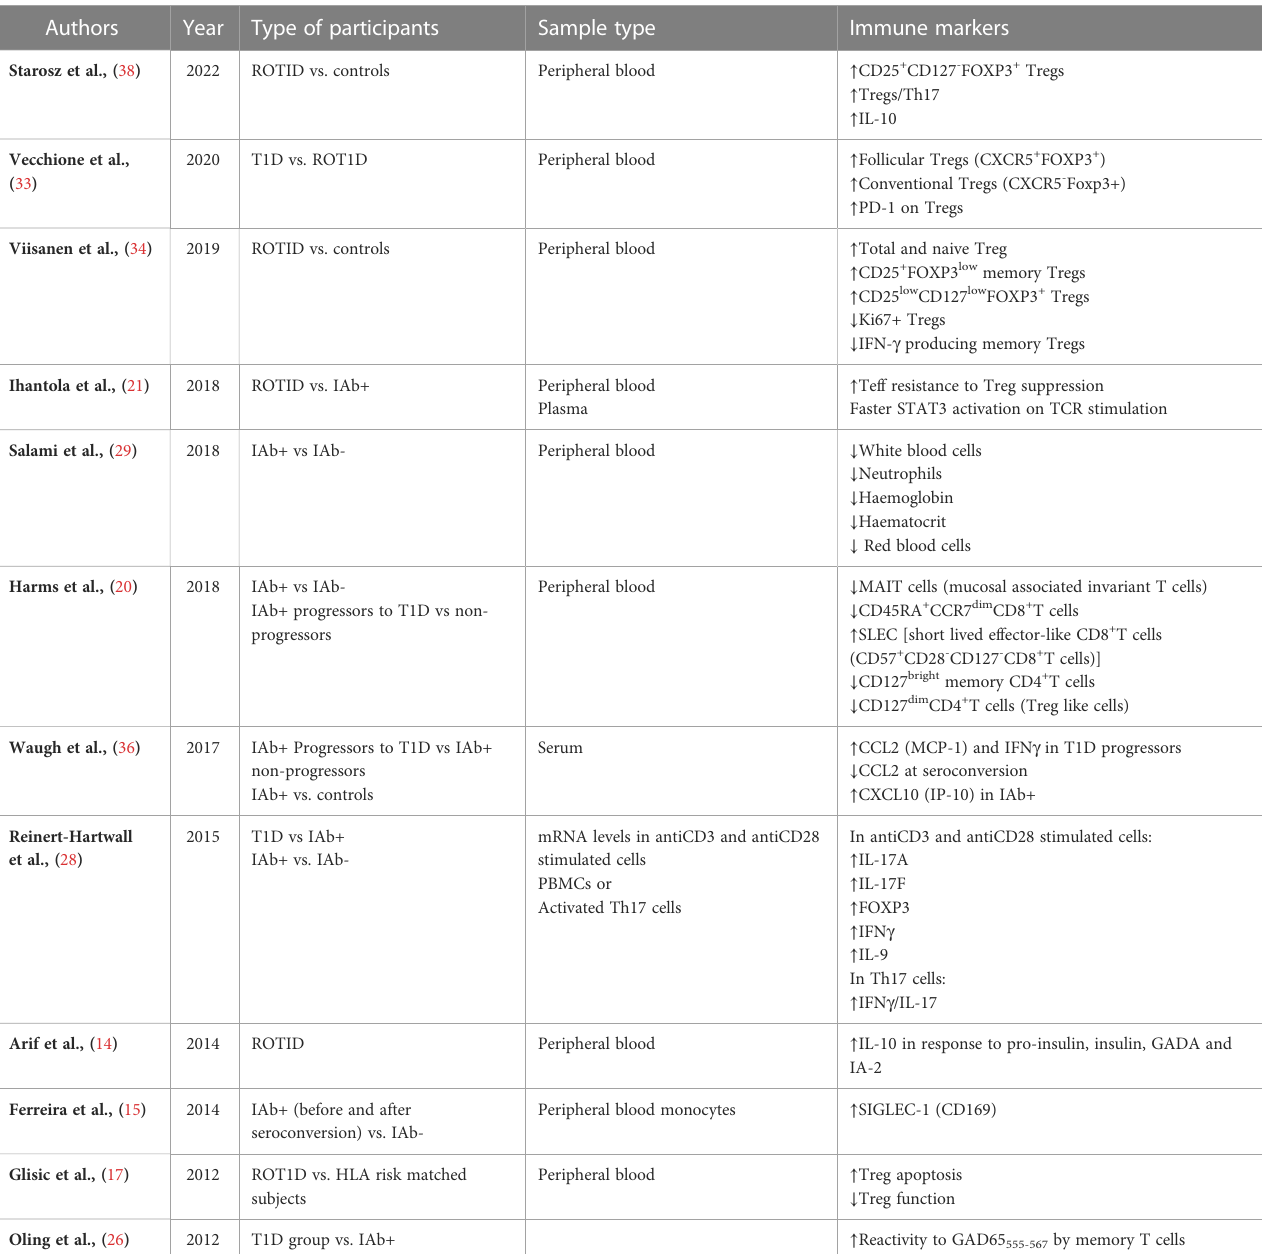
TABLE 2 Immunological markers linked to progression to T1D or islet